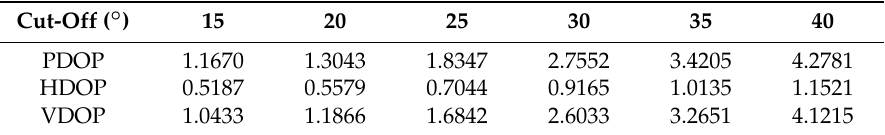
Table 2. Mean DOPs of GPS/BDS/GLONASS for 15° to 40° cut-off elevation angles.